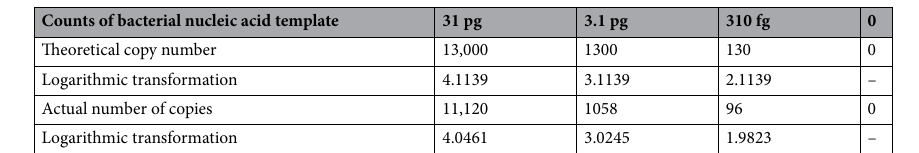
Table 2. Dynamic range of the ddPCR-based assay. Detecting the Staphylococcus aureus ATCC25923 nucleic acid template by ddPCR system.